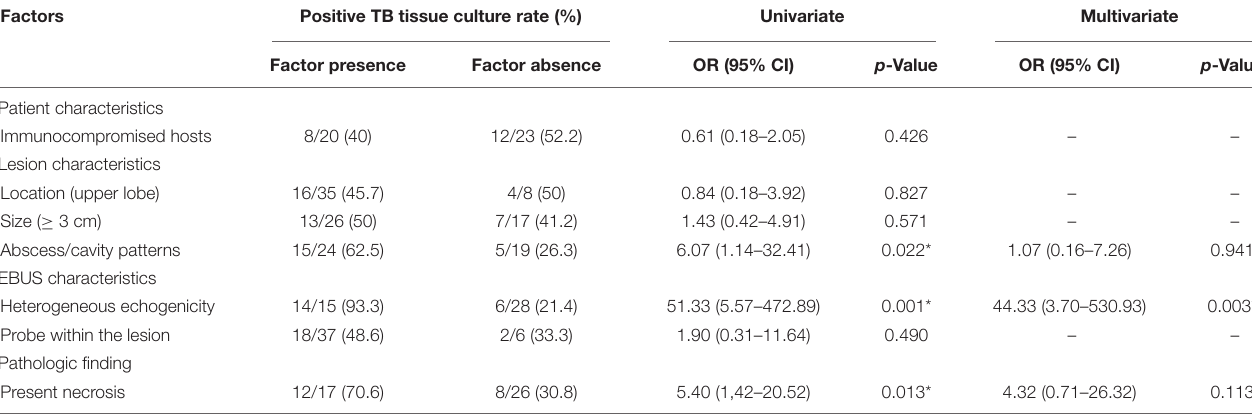
TABLE 5 | Logistic regression analysis of factors influencing the positive TB culture rate of washing fluid and tissue specimen.